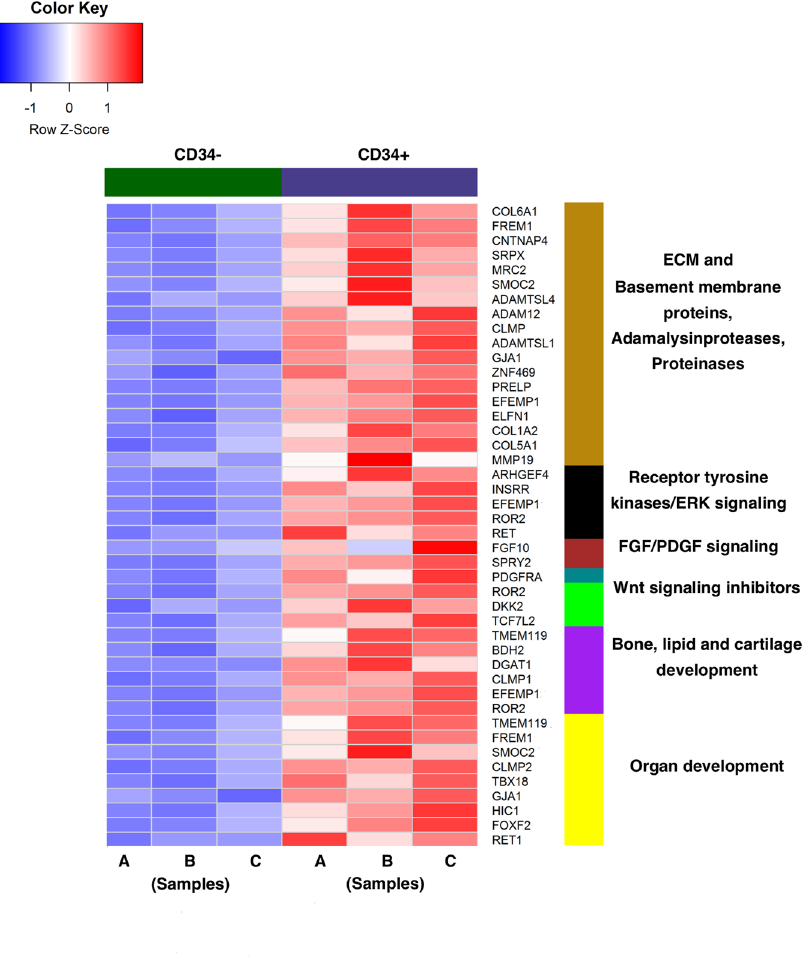
Figure 5. RNA sequence profiling of CD34 cells derived from human fetal SMGs. Heat map shows genes significantly upregulated in CD34 + population as compared to CD34 −